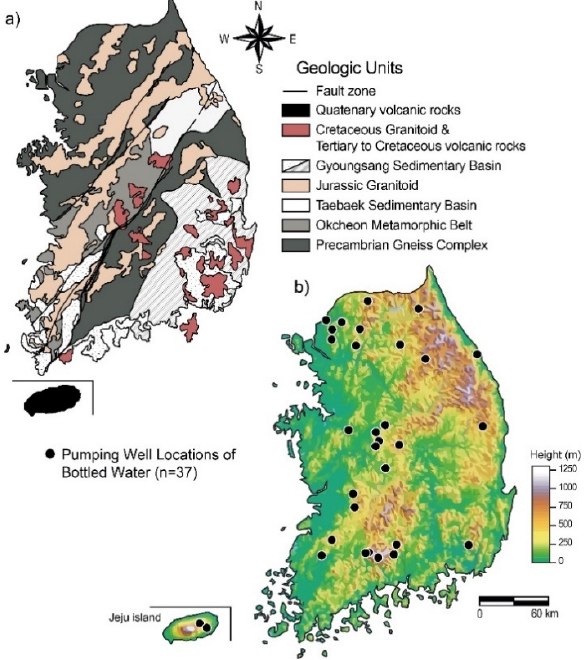
Figure 1. Maps of South Korea, showing ( a ) regional geology and ( b ) topography (elevation in m above sea level) with borehole locations for bottled water production ( n = 37). In ( a ), Cretaceous granitoids and Tertiary to Cretaceous volcanic rocks are shown as one because they often occur together in time and space. In ( b ), 32 points are shown because 5 wells are located very close to the others at this